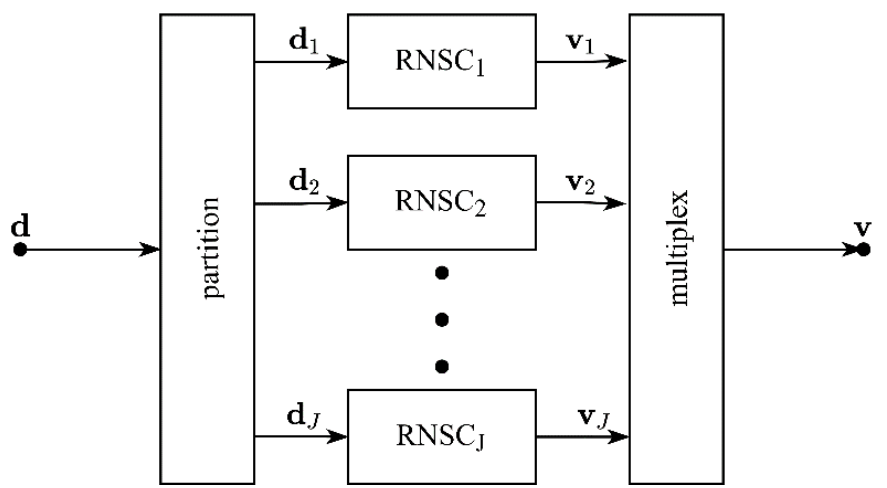
Figure 2. Irregular channel encoder.